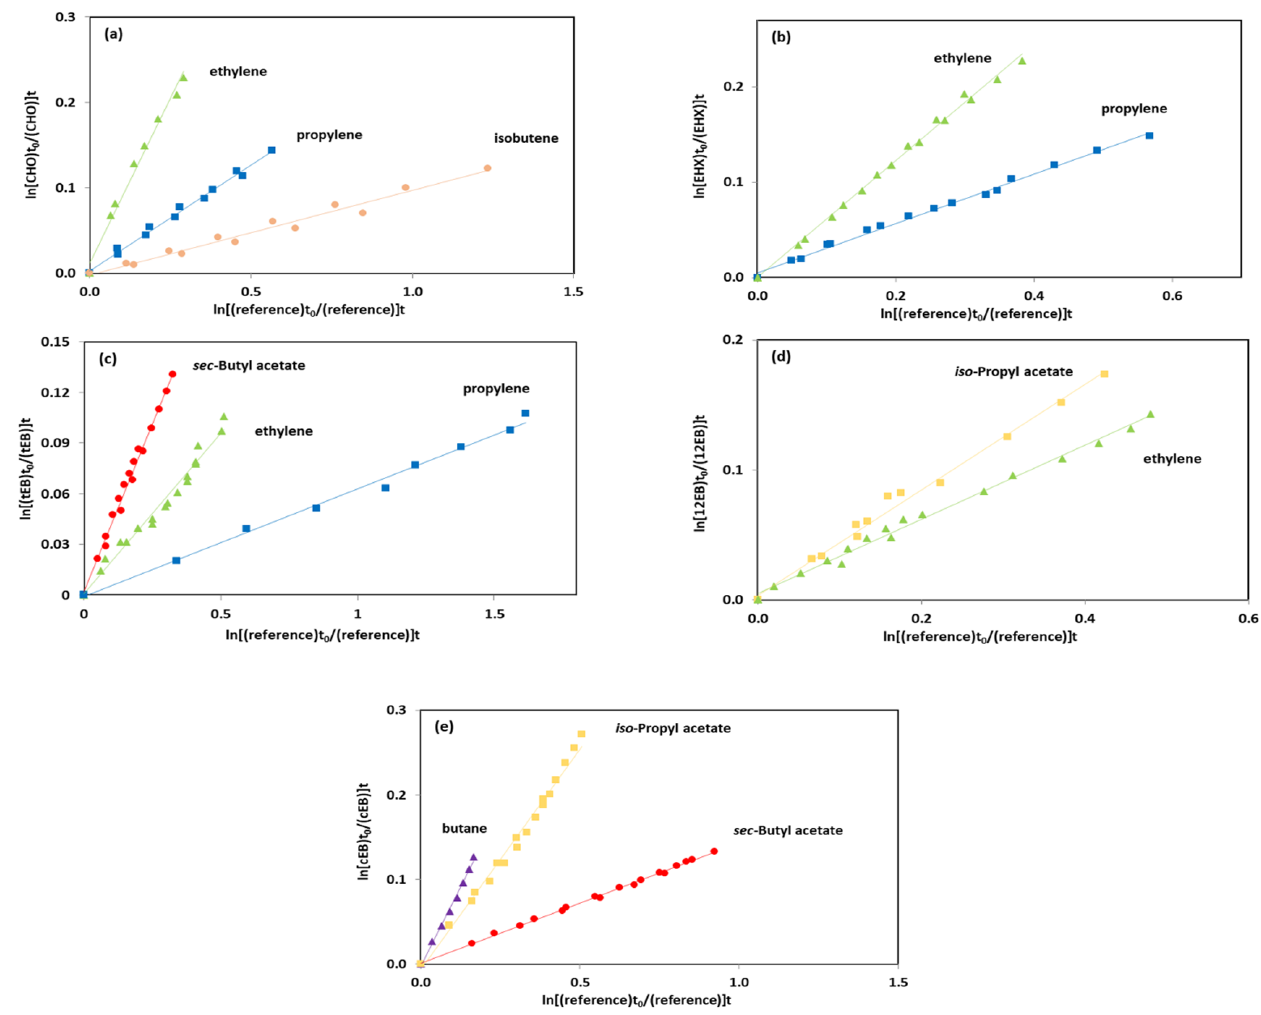
Figure 1. Kinetic data for the reaction of OH radicals with (a) CHO, (b) EHX, (c) t EB, (d) 12EB and (e) c EB using ethylene, butane, sec -butyl acetate, iso -propyl acetate and propylene as reference